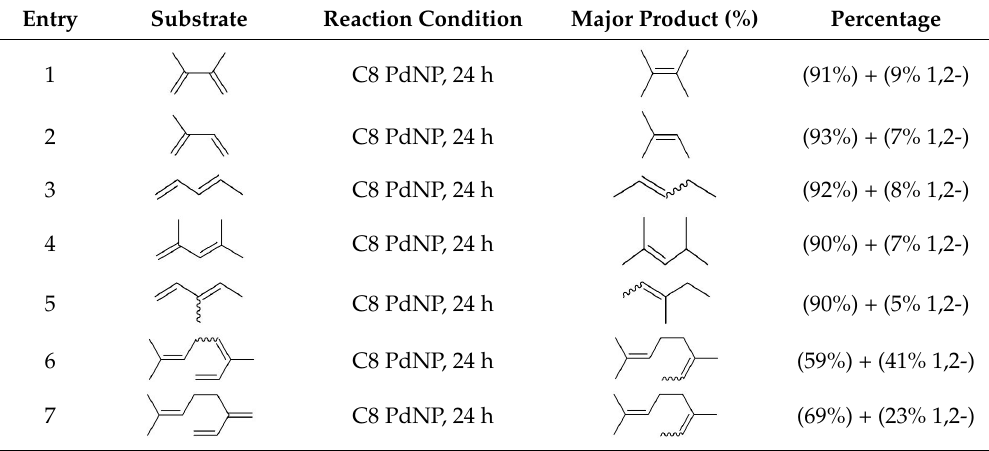
Table 4. Selective hydrogenation of dienes and trienes by alkanethiolate-capped PdNP (5 mol